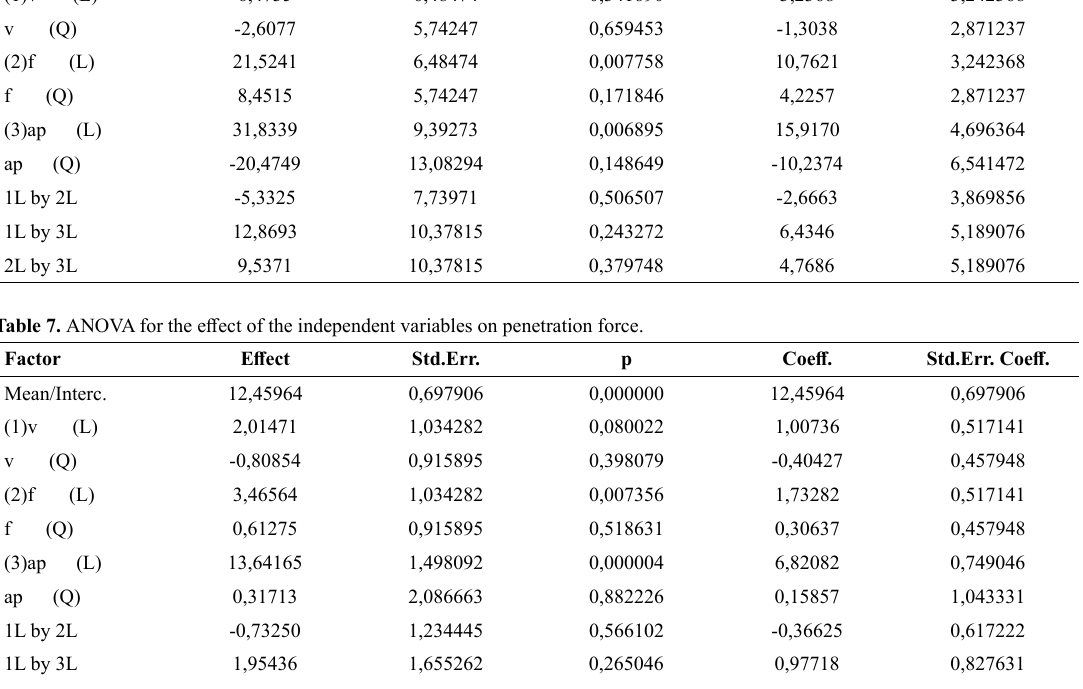
21,5241 6,48474 0,007758 10,7621 3,242368